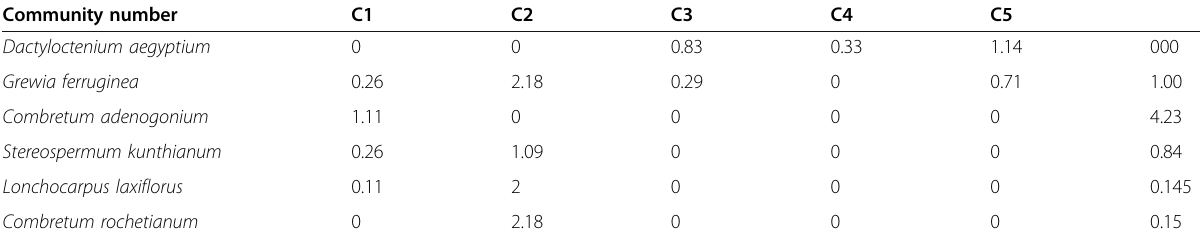
Table 2 Species list with synoptic cover-abundance values for species having a value of ≥ 1 at least one in a community type (Continued)